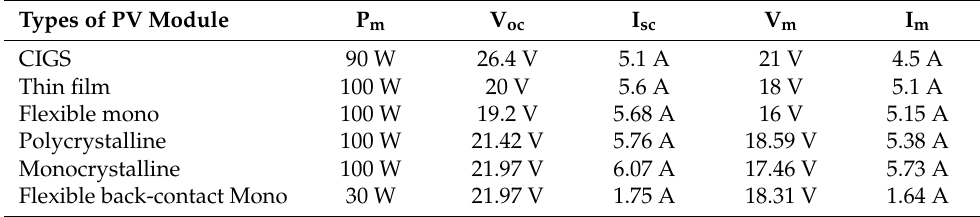
Table 2. The technical characteristics at